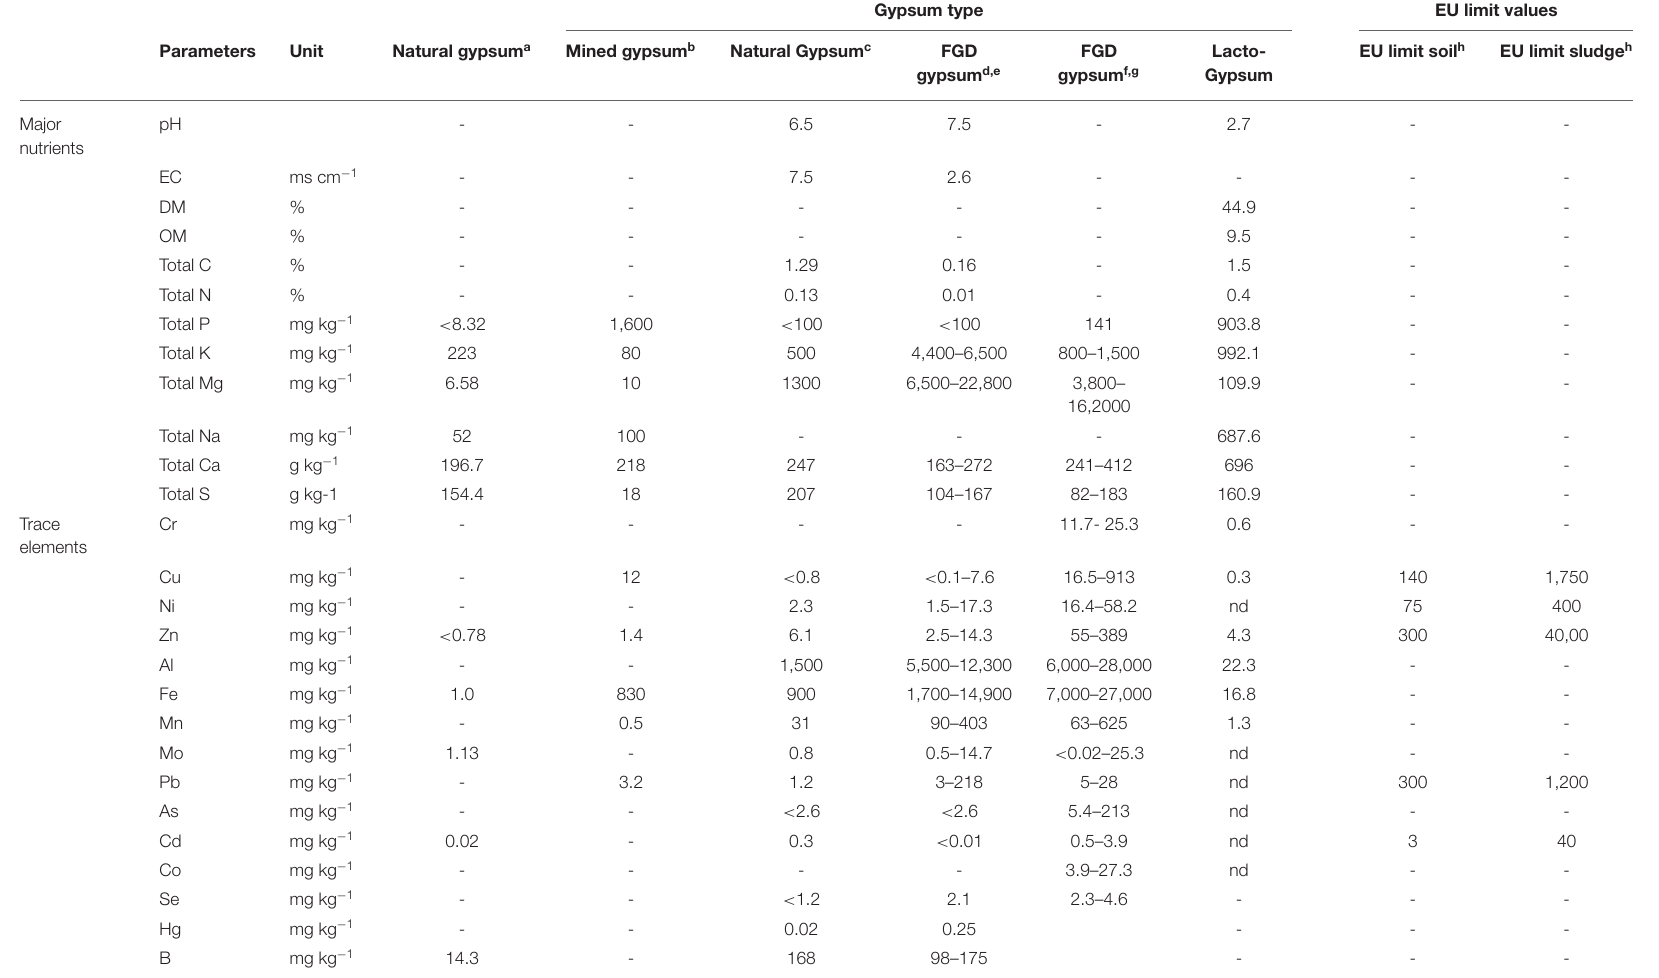
TABLE 1 | Characterization of different Gypsum types in use and lacto-gypsum tested in this study